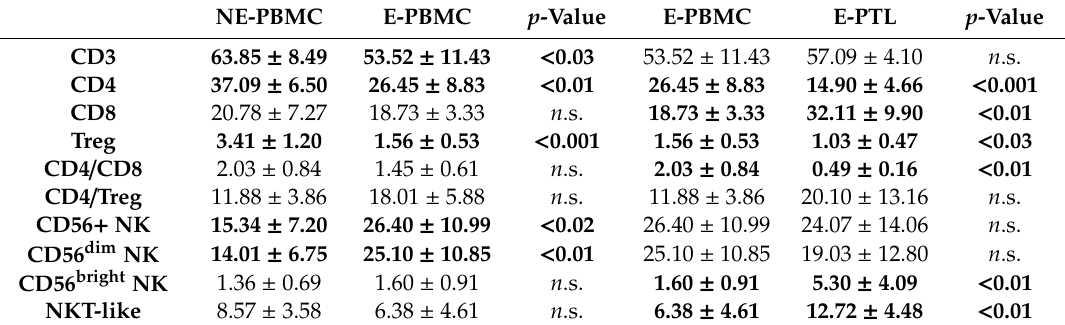
Table 2. Phenotype characteristics of the analyzed mononuclear cell populations.